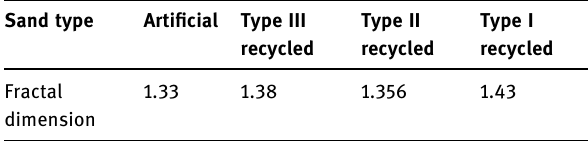
Table 4: Fractal dimension of sand outline in single particle